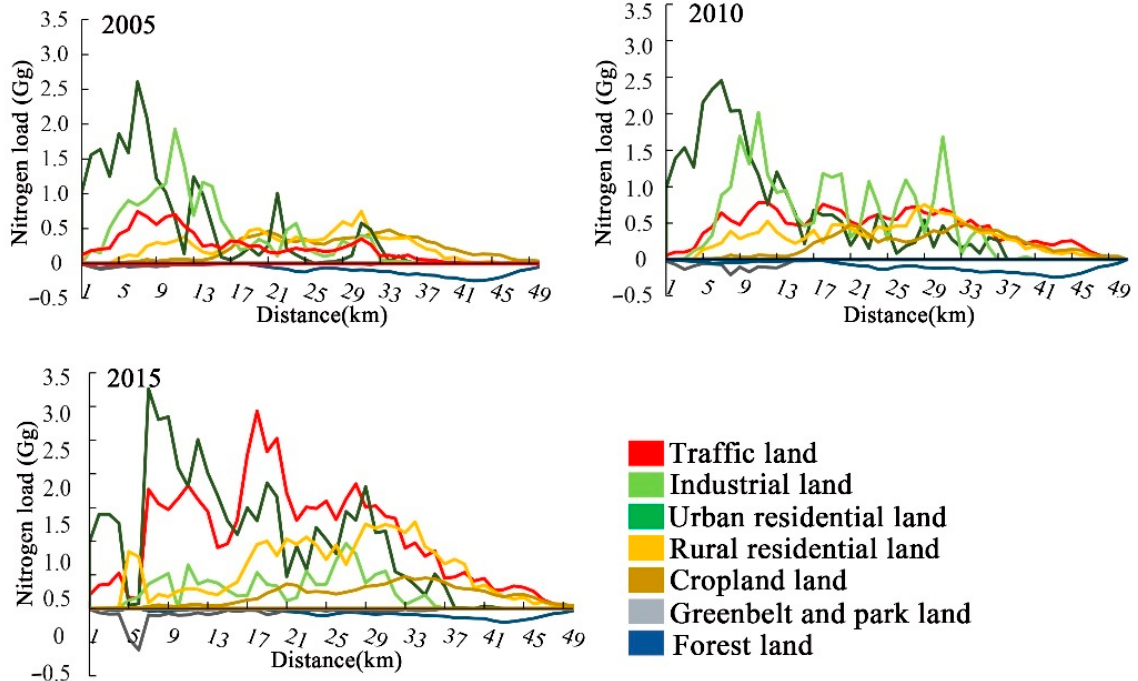
Figure 7. N loads of different landscape types along the spatial gradient.